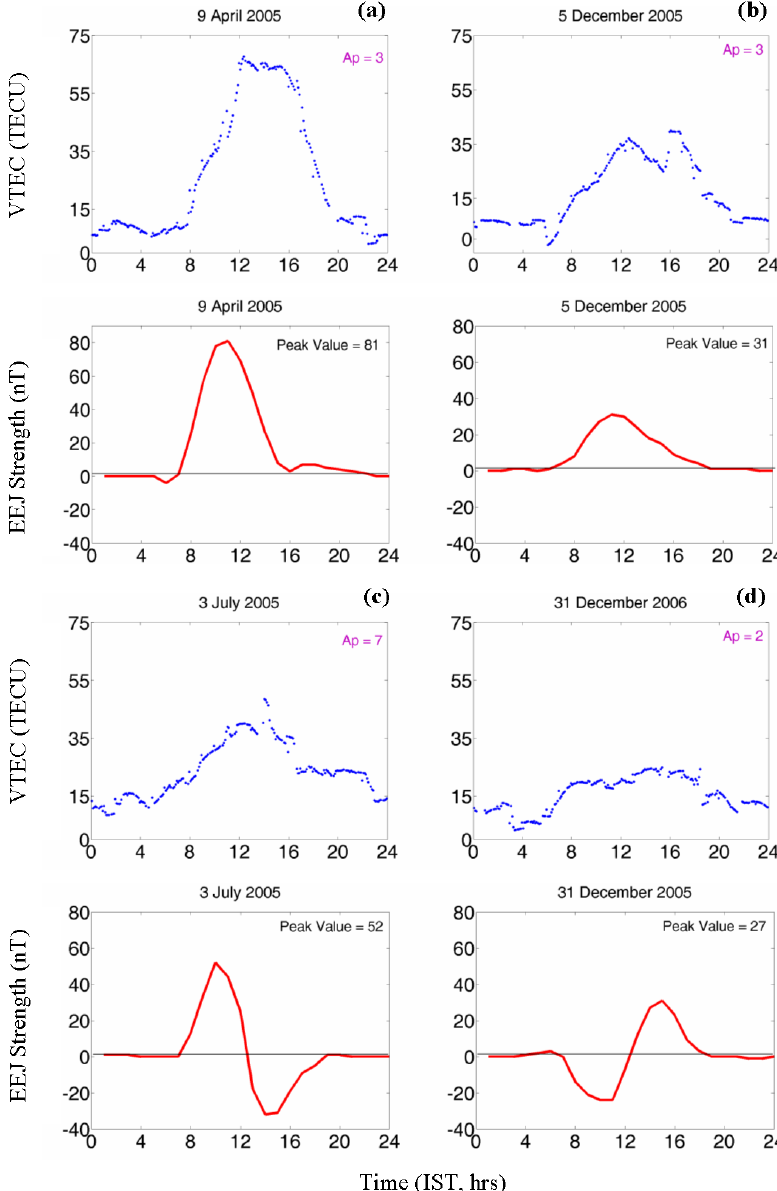
Fig. 8. EEJ control on diurnal variation of TEC on the day of (a) 9 April 2005, (b) 3 July 2005, (c) 5 December 2005, (d) 31 December 2006, representing Strong, Weak, Afternoon Counter Electrojet and Morning Counter Electrojet conditions,